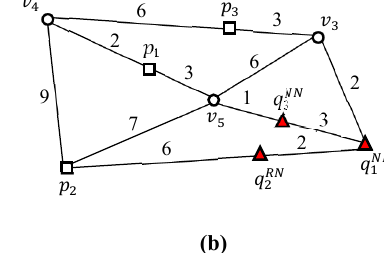
Figure 1. Snapshots of a set of SP queries, Q in a dynamic spatial network, where Q = { q NN ( b ) At time t j .